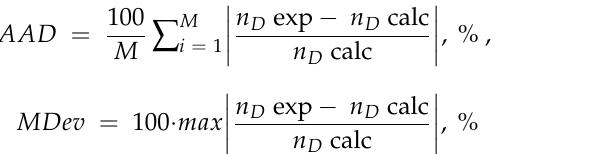
Equation Equation (22).